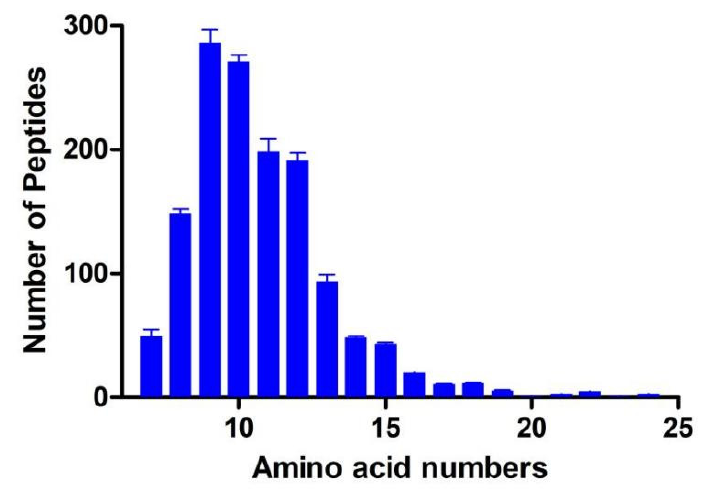
Figure 1. Distribution of peptides numbers in GP.